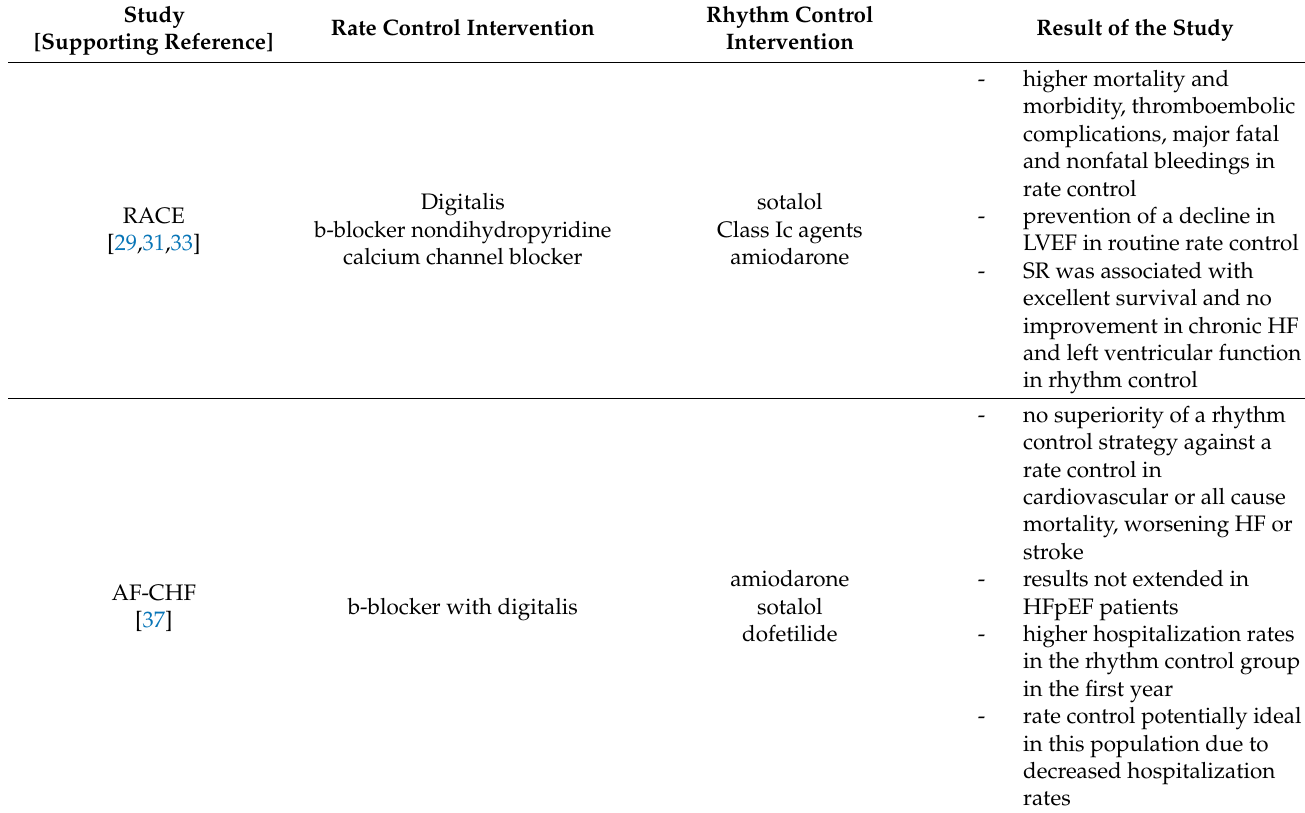
Table 1. A summary of the studies comparing rhythm vs. rate control